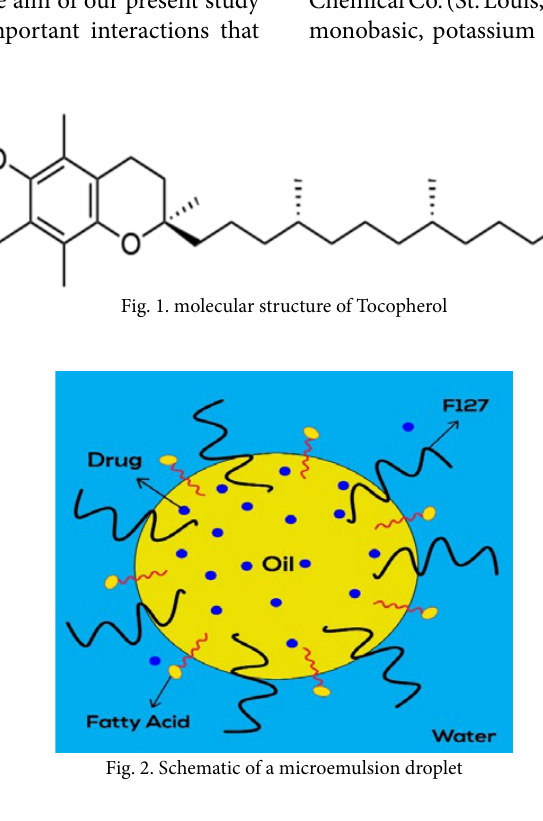
Fig. 2. Schematic of a microemulsion droplet